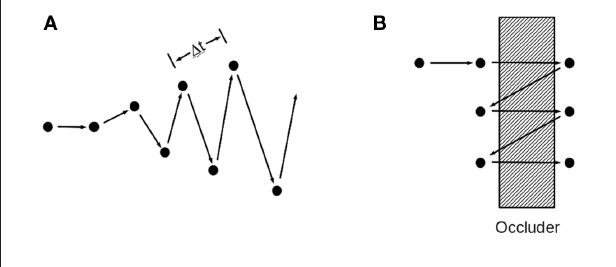
Figure 2 | Trajectories predicted to be perceived as violating object persistence by infants and, at high velocity, by adults. (A) A zig-zag trajectory with velocity increasing to maintain a constant value of ∆ t between extreme points, which is predicted to appear as a single object splitting into two objects that follow divergent paths. (B) An occluded zig-zag, which is predicted to appear as two objects falling down opposite sides of